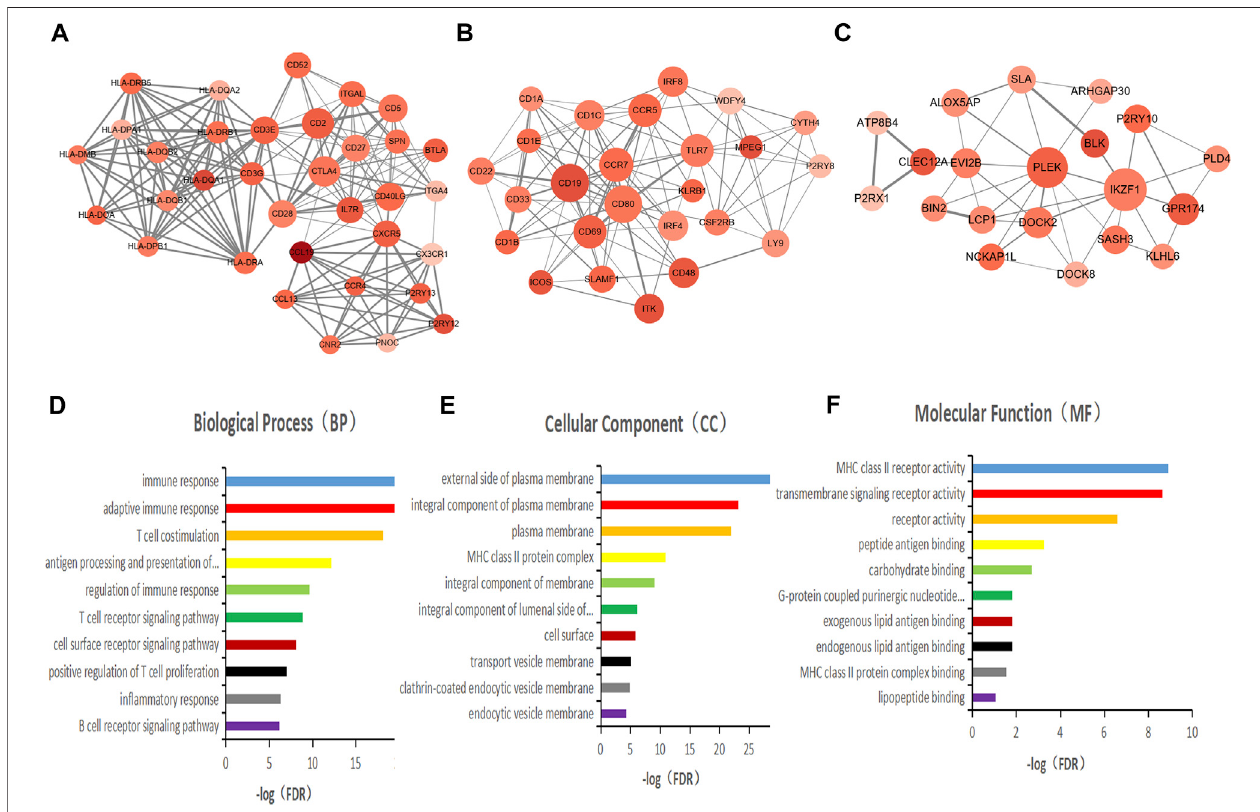
FIGURE 3 | PPI network was constructed to screen the key genes of immune function. (A – C) Interaction network constructed with the nodes with interaction con fi dence value > 0.5. The color of the nodes in the PPI network re fl ects the log(FC) value of the Z value of gene expression, and the size of the nodes represents the number of proteins interacting with the speci fi ed protein. (D – F) Top 10 GO terms of the mode gene in fi gure A. False discovery rate (FDR) of GO analysis was acquired from DAVID functional annotation tool, p < 0.05.